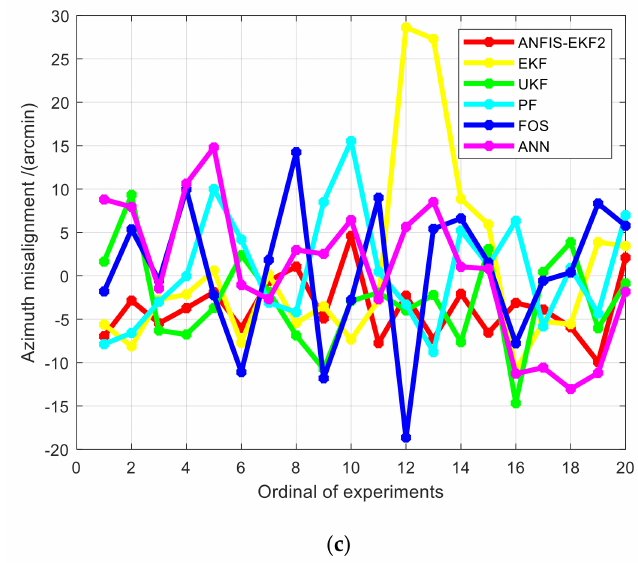
Figure 9. The statistical chart of alignment results of each filtering algorithm in Experiment 1. ( a ) East